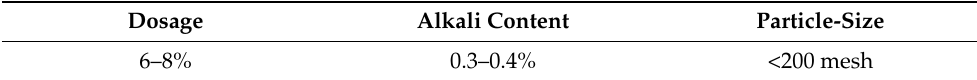
Table 3. Expansion agent parameter table.